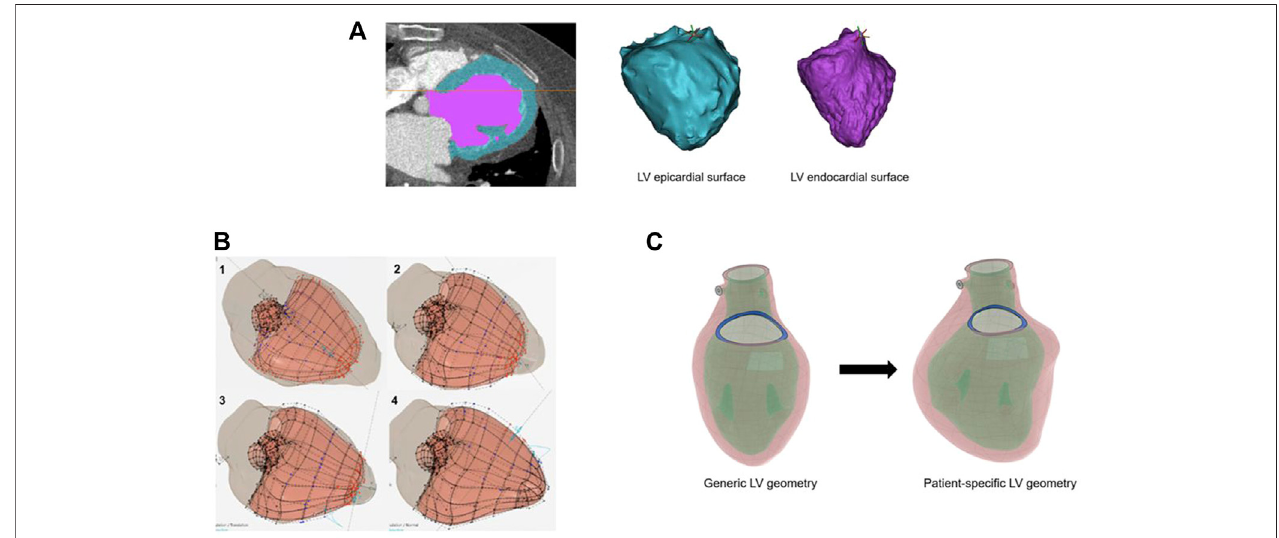
FIGURE 1 | (A) Image segmentation of the left ventricle from computed tomography imaging. The left ventricle (LV) wall is in blue, and the LV cavity is in purple. At right are the three-dimensional surfaces representing the LV epicardial and endocardial surface boundaries. (B) The CATIA ™ software allows rapid alignment of the generic model (salmon-colored model) to patient-speci fi c imaging surfaces (left ventricle shadow overlay shown in gray). Alignment of the generic epicardial surface to patient-speci fi c epicardial surface: 1) initial overlay, 2) alignment of the basal segments, 3) mid-wall segments, 4) apical segments. (C) Overview of the generic left ventricle geometry transformed to patient-speci fi c geometry after application of the Smart Geometry